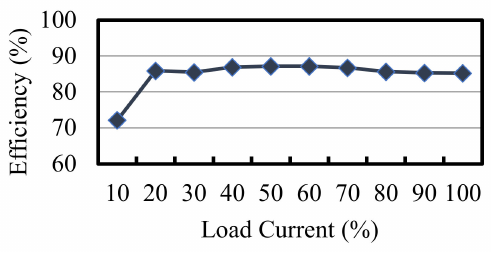
Figure 20. Curve of efficiency versus load current.